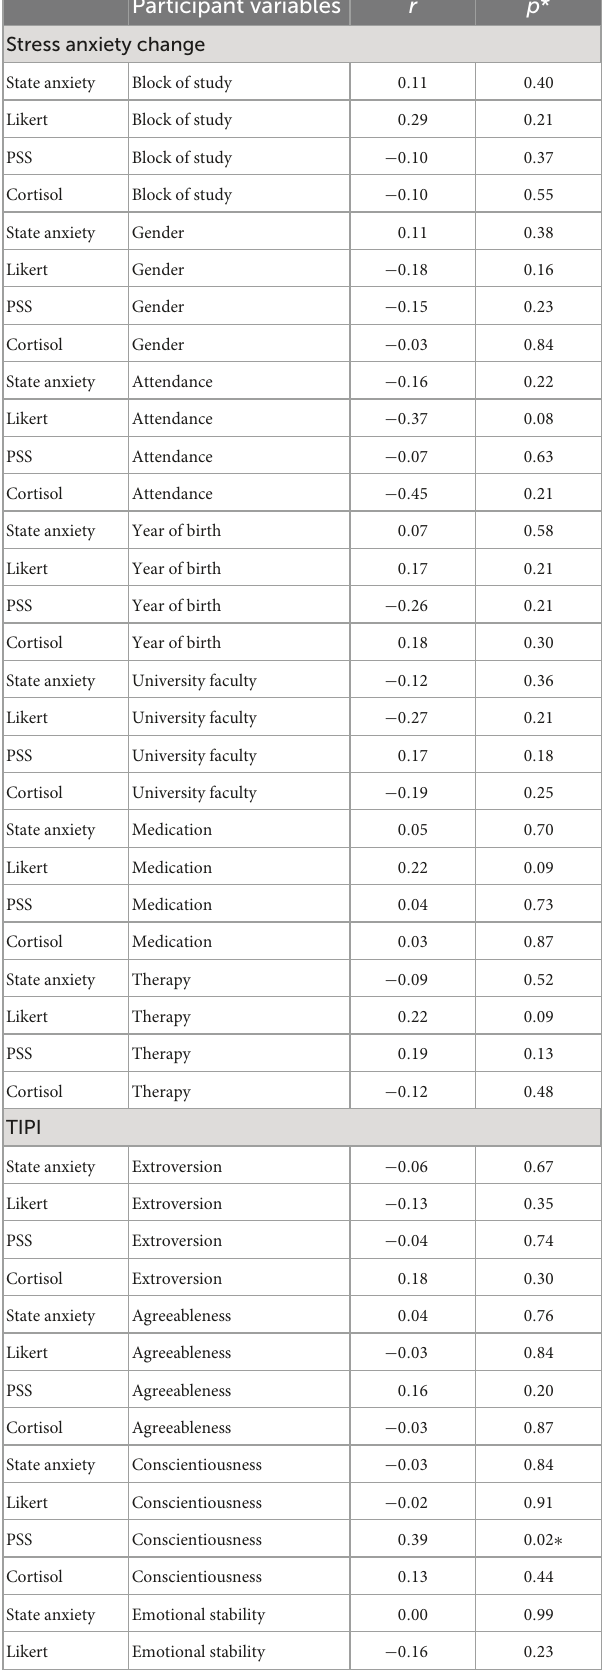
TABLE 3 Correlates of stress and anxiety difference